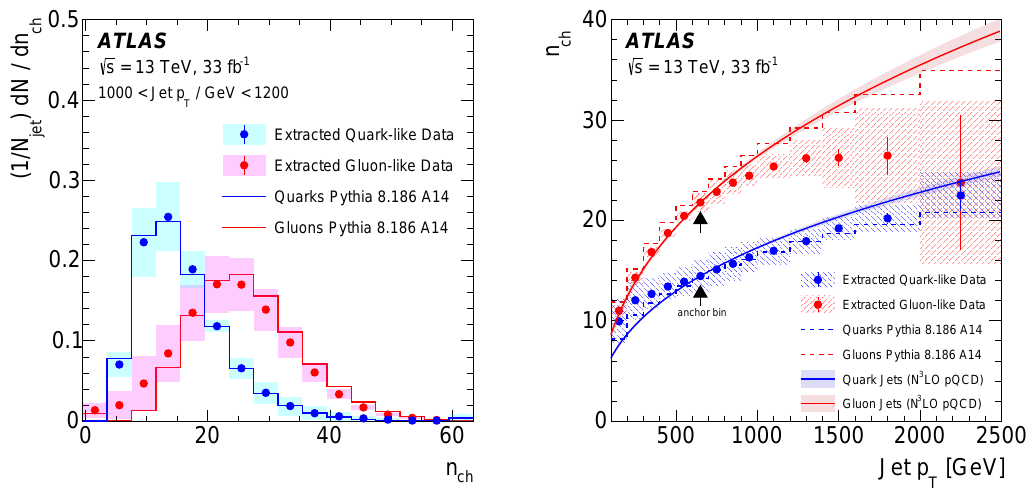
Figure 1: Distribution of the number of charged particles within the jet for quark and < 1.2 TeV (left). Average value of the number of charged gluon jets with 1 TeV < p T 〉 within quark and gluon jets as a function of the jet p particles 〈 n ch